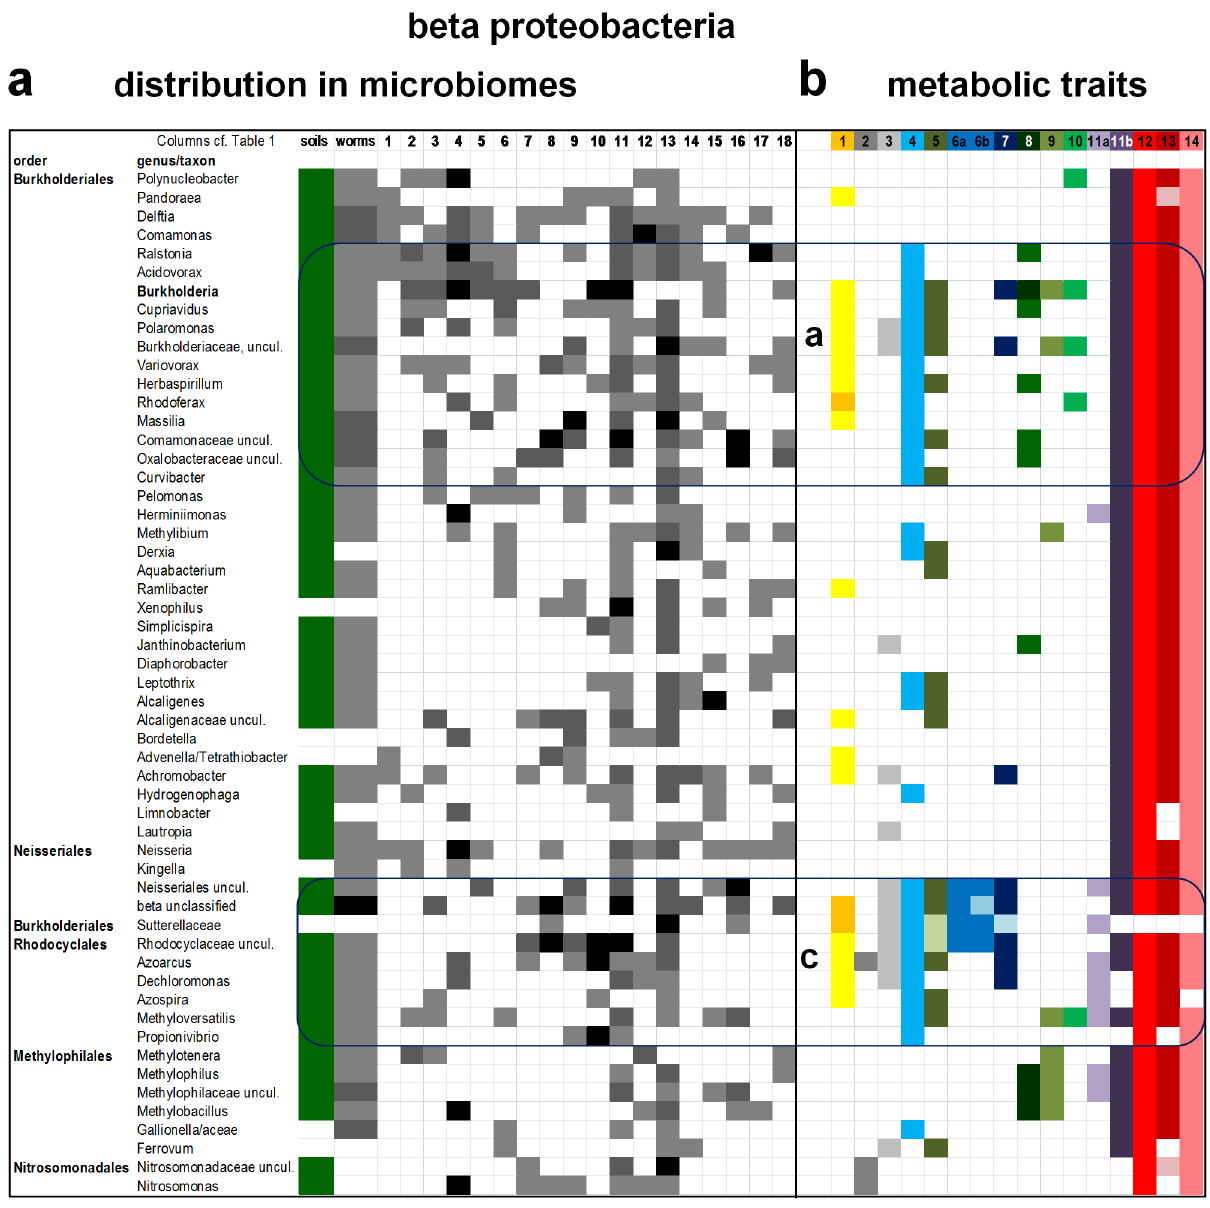
Fig 3. Visualization of the taxonomic distribution and metabolic traits of beta proteobacteria in the microbiome of soils, C . elegans and 18 arthropods. Taxa of beta proteobacteria in the microbiomeof soils and invertebrates were organizedas in Fig 1. a. The relative abundance of beta proteobacterial taxa in each microbiomewas renderedin grayscaleas presented in Fig 1 and describedin the Methods. See S1 Table for quantitative detailsof bacterialabundance. The distribution of taxa forms variousclusters from the top to the bottom of the phylogenetically organized sequenceas for alpha (Fig 1) and gamma (Fig 2) proteobacteria. b. The mappingof the14 metabolictraits considered for the functionalprofile of microbiomes (Table 2) segregates two functionalgroups: group a (within the order of Burkholderiales, top) and group c (containingSutterellaceae, some Neisseriales, unclassified beta and Rhodocyclales, bottom). These groups are well definedby statistically significantdifferences in Jaccard index and are rather similar to each other (see Fig 4C). Conversely, the scattered distribution of metabolictraits in the middleof the distribution did not allow the definition of another functionalgroup for lack of statisticallysignificantdifferenceswith surroundingtaxa.